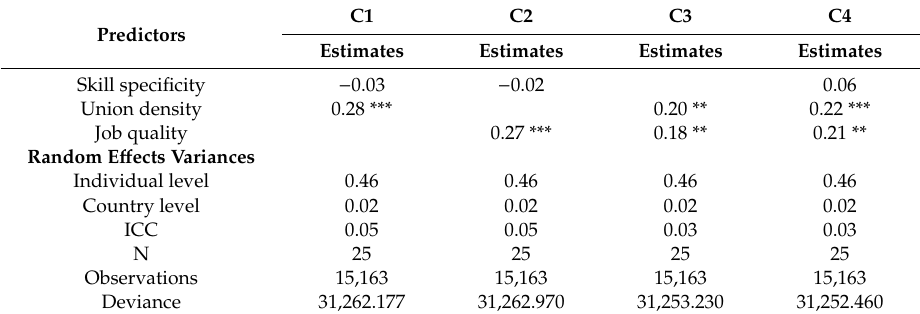
Table 3. E ff ects of skill specificity and union density on job preference orientations, controlling for country-level job quality—a multi-level